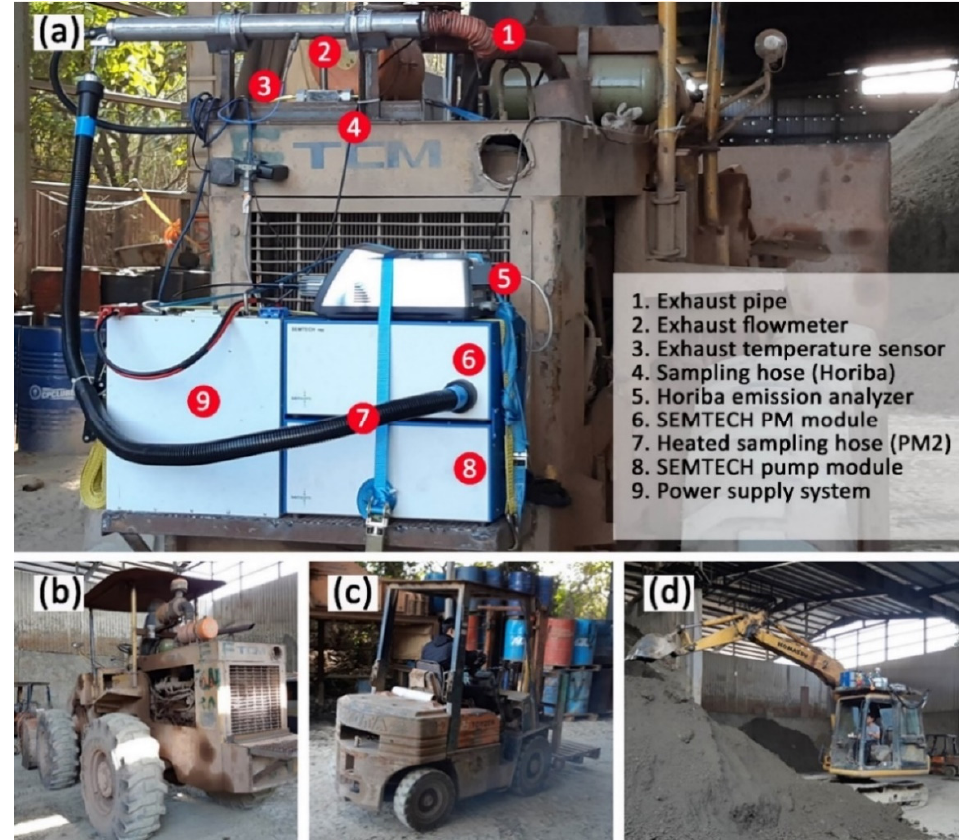
Figure 1. Emission measurement system and test machines: ( a ) components of the onboard emission